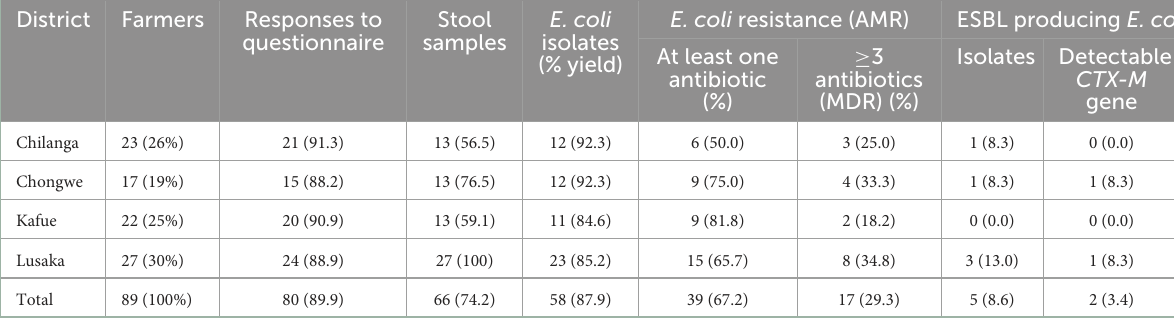
TABLE 1 Distribution of farmers, samples, E. coli isolates and ESBL producing E. coli . District Farmers